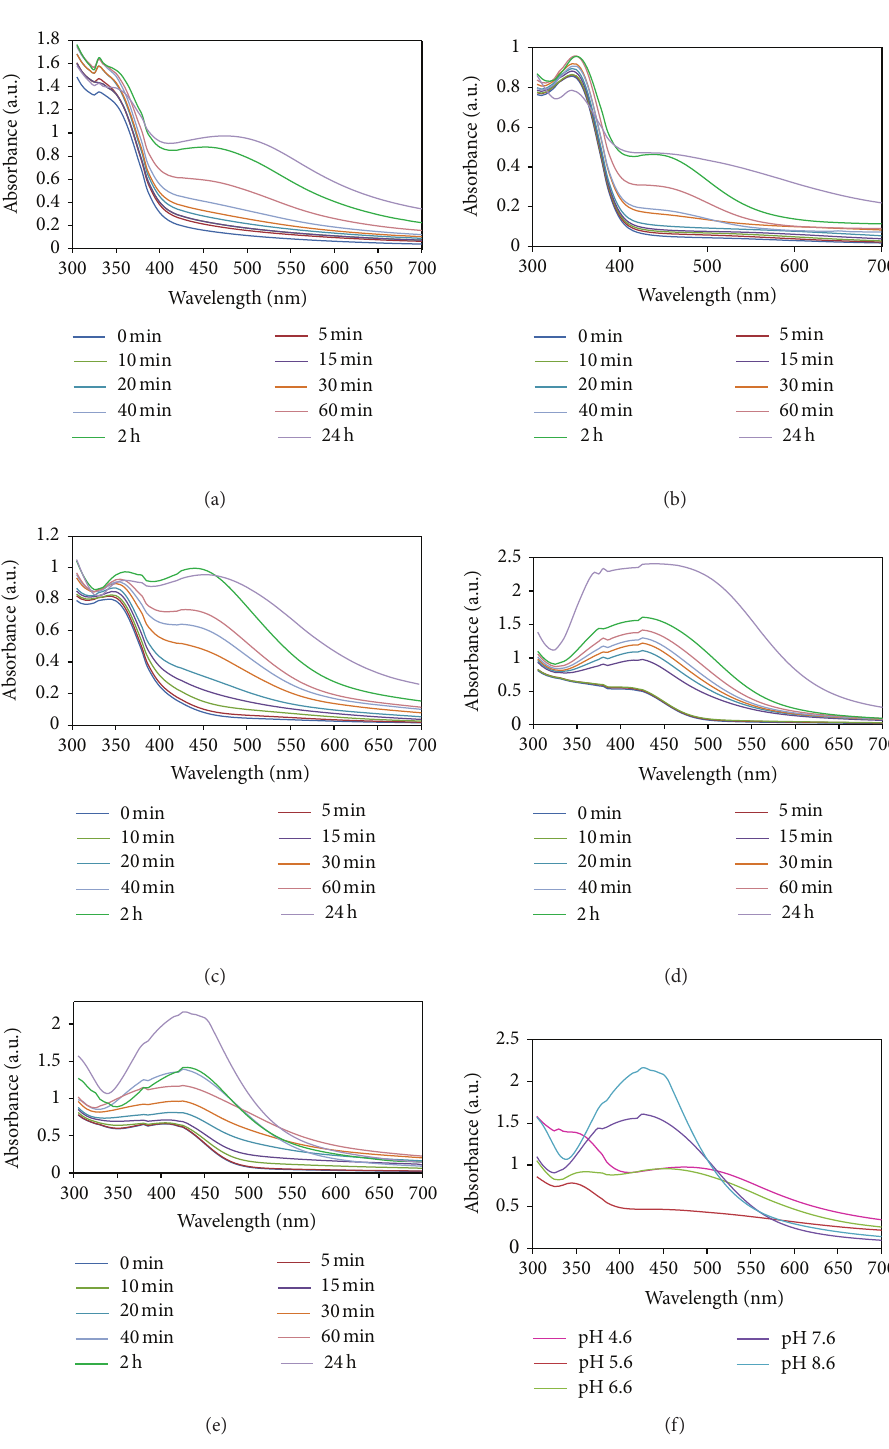
Figure 2: UV-vis spectrum of silver nanoparticle synthesized by leaf extract of M. tinctoria recorded at different pH ((a) pH 4.6 (b) pH 5.6 (c) pH 6.6 (d) pH 7.6 (e) pH 8.6) and different incubation period (0–24 h), (f) Comparison of synthesized silver nanoparticle at different pH from 4.6 to 8.6 and the incubation time is 24